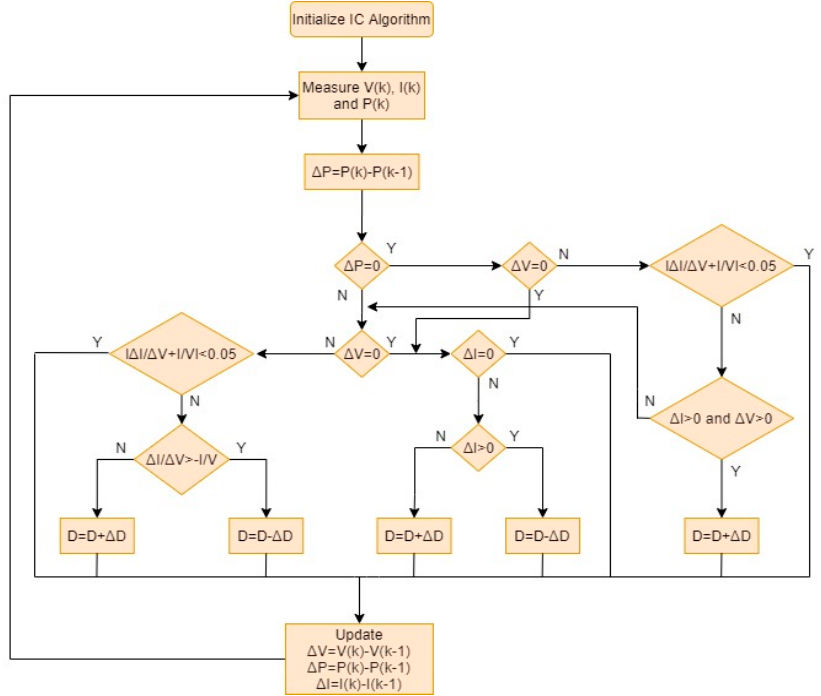
Figure 5. Modified IncCond algorithm flowchart.